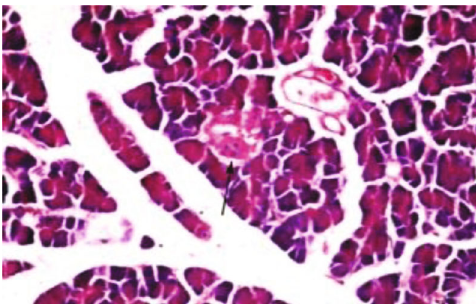
Figure 6: Photomicrograph of pancreatic tissue of F. carica (100mg/kg BW)-treated animal showing pancreatic islet reduced in size and cellularity with vacuolation in between cells (arrowhead) (H&E) ( × 400).